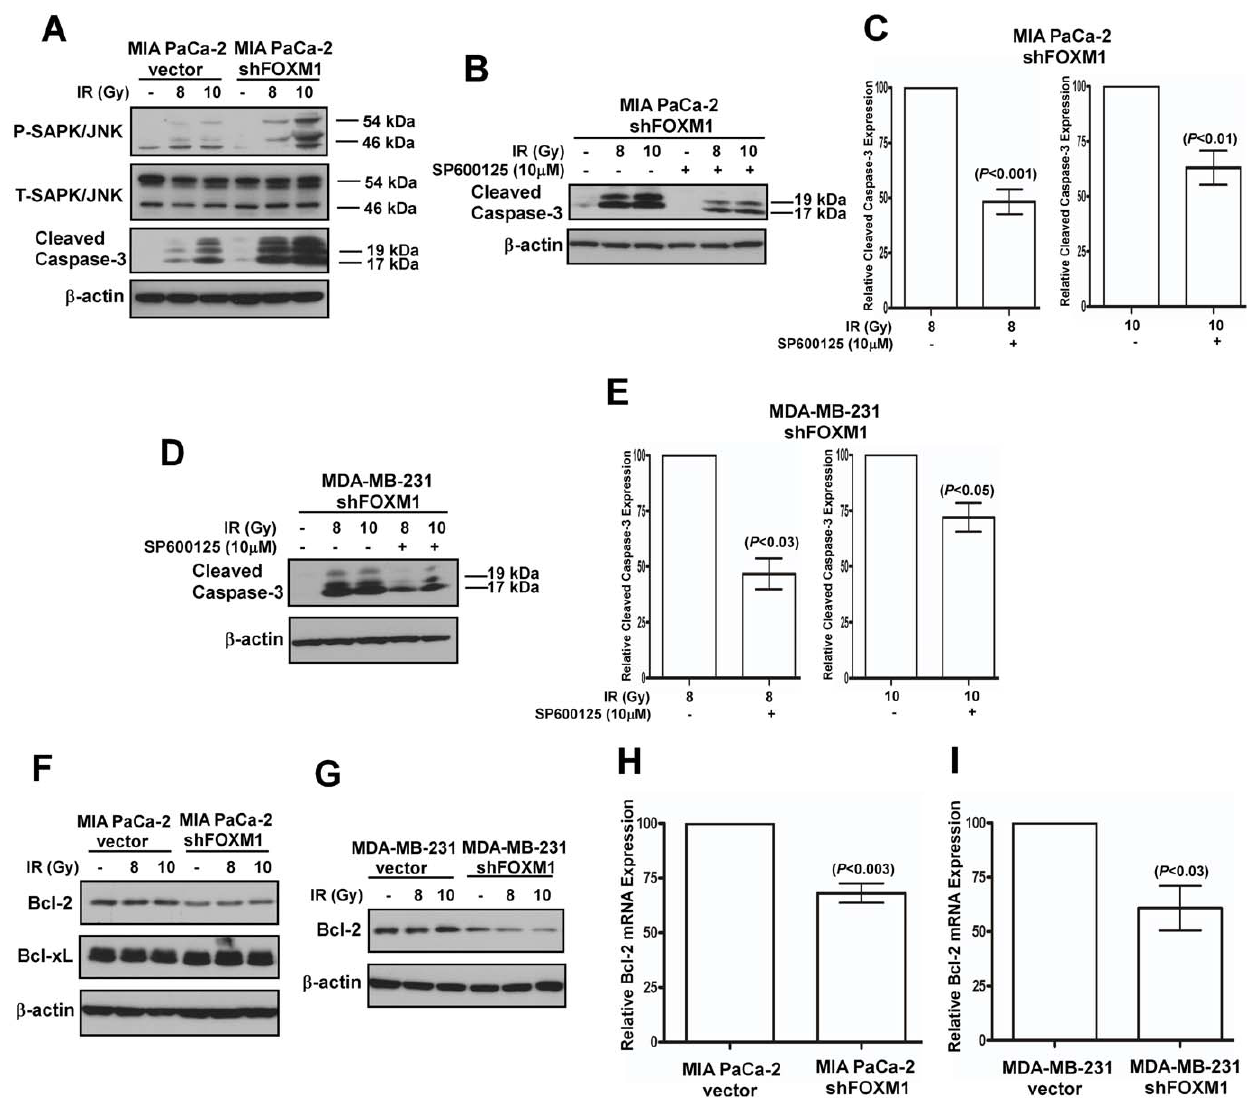
Figure 4. FOXM1 modulates JNK activity and Bcl-2 expression to sensitize human cancer cells to DNA-damage. ( A ) MIA PaCa-2 control and FOXM1 knockdown pancreatic cancer cells were c -irradiated with the indicated doses. Seventy-two hours following irradiation cells were harvested and immunoblotting was carried out with antibodies specific for Phospho/Total-SAPK/JNK and cleaved caspase-3. b -actin was used as the loading control. ( B ) MIA PaCa-2 FOXM1 knockdown pancreatic cancer cells were preincubated for 1 hour with 10 m M of JNK inhibitor, SP600125 and then were c -irradiated as indicated. Forty-eight hours following irradiation cells were harvested and immunoblotting was performed for cleaved caspase-3 and b -actin as the loading control. ( C ) The graphs show mean values 6 SEM of four independent experiments. ( D ) MDA-MB-231 FOXM1 knockdown breast cancer cells were preincubated for 1 hour with 10 m M of JNK inhibitor, SP600125 and then were subjected to c -irradiation with the indicated doses. Seventy-two hours after irradiation cells were harvested and immunoblotting was performed with cleaved caspase-3 and b -actin antibodies. ( E ) The graphs show mean values 6 SEM of two independent experiments. ( F ) Pancreatic MIA PaCa-2 control and FOXM1 knockdown cancer cells were subjected to ionizing radiation with the indicated doses. Thirty-six hours following irradiation cells were harvested and immunoblotting was carried out with antibodies specific for Bcl-2 and Bcl-xL. b -actin was used as the loading control. ( G ) Breast MDA-MB-231 control and FOXM1 knockdown cancer cells were c -irradiated as indicated. Seventy-two hours following irradiation cells were harvested and immunoblotting was performed for Bcl-2. b -actin was used as the loading control. ( H ) MIA PaCa-2 control and FOXM1 knockdown pancreatic cancer cells were harvested for RNA extraction. Quantitative RT-PCR was carried out with Bcl-2 and cyclophilin primers. The graph demonstrates mean values 6 SEM of three independent experiments. ( I ) To extract RNA MDA-MB-231 control and FOXM1 knockdown breast cancer cells were harvested. Using Bcl-2 and cyclophlin primers qRT-PCR was performed. The graph shows mean values 6 SEM of three independent